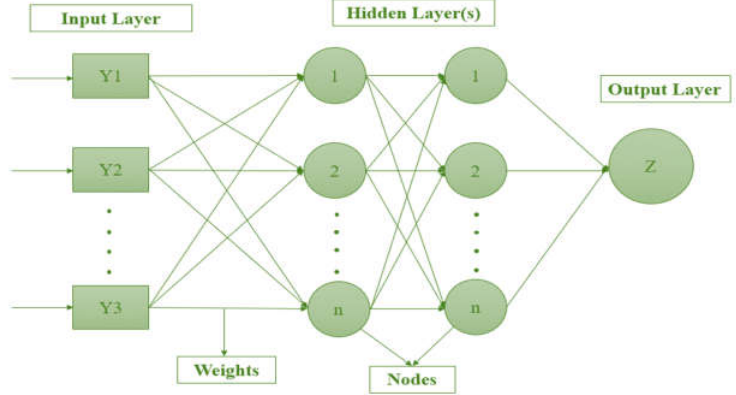
Figure 1. ANN multilayer perceptron structure.